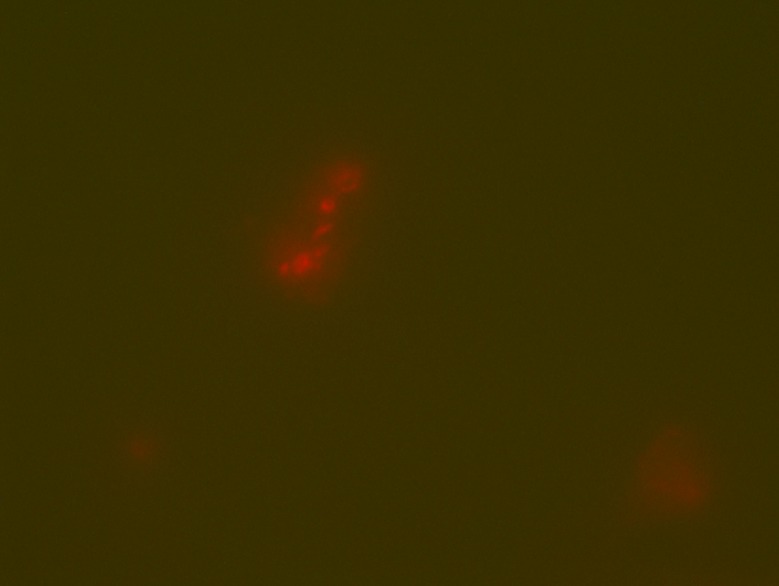
EDTA demineralised Late Cretaceous surface eroded fossil bone at 691 m elevation in Dinosaur Provincial Park showing possible cell clusters as might be expected in a biofilm (image 2).Sample ID as in Appendix 1—table 2: 16B.